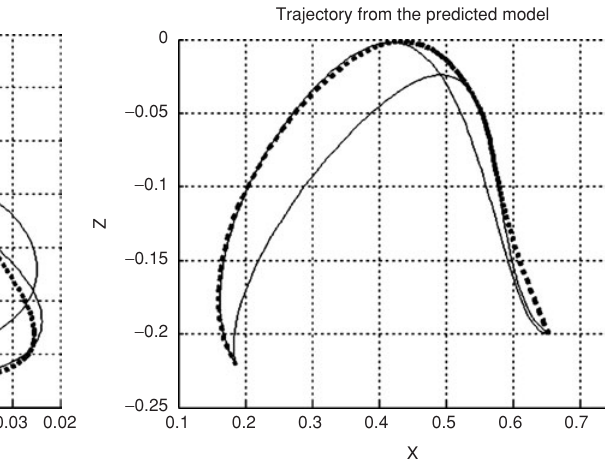
Figure 16 Simulated trajectory. (a) XY plane. (b) XZ.